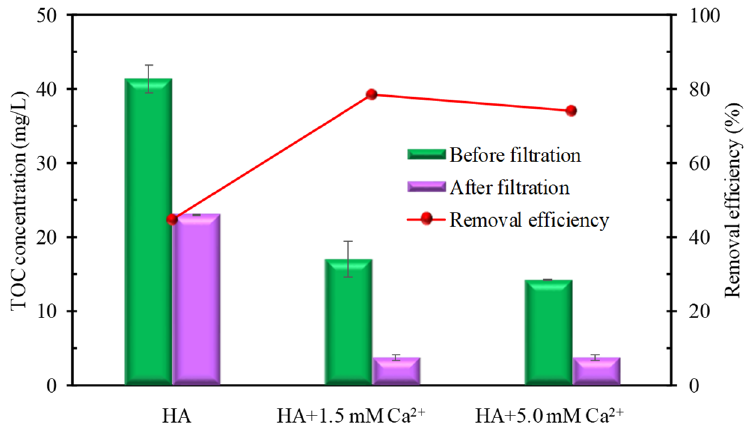
Figure 6. TOC content and removal efficiency of HA with different Ca 2+ concentrations.